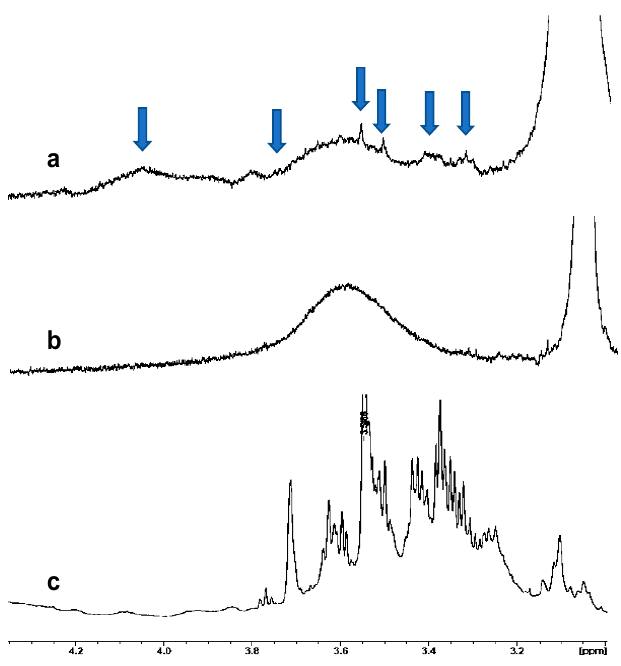
Figure 4. Comparison of the 1 H-NMR spectra in DMSO-d 6 of ( a ) PCE encapsulated in p NIPAM, ( b ) p NIPAM and ( c ) PCE.